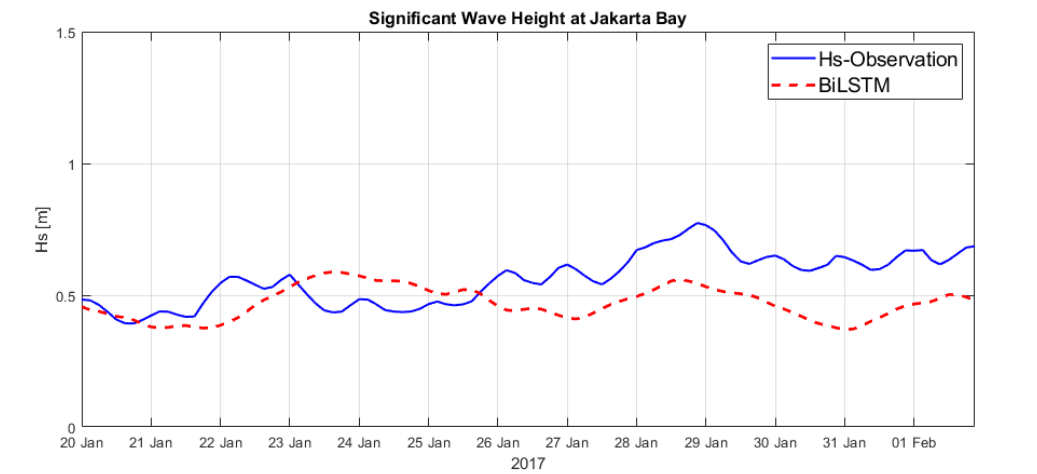
Figure 12. Comparison of significant wave height from wave observation with result of prediction by using BiLSTM at Jakarta Bay.